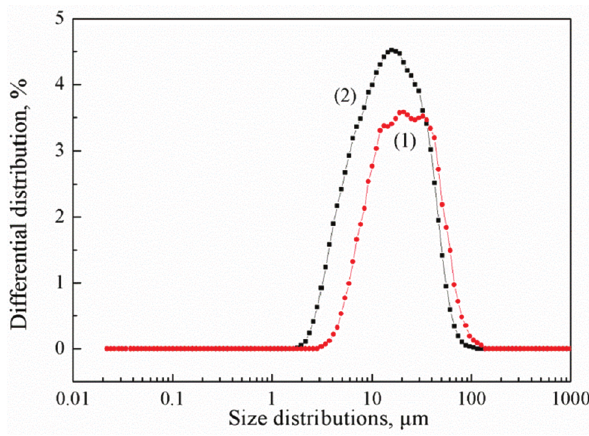
Figure 6: Size distribution of rare earth carbonates under different conditions: (1)-Drying using oven; (2)-Drying using microwave